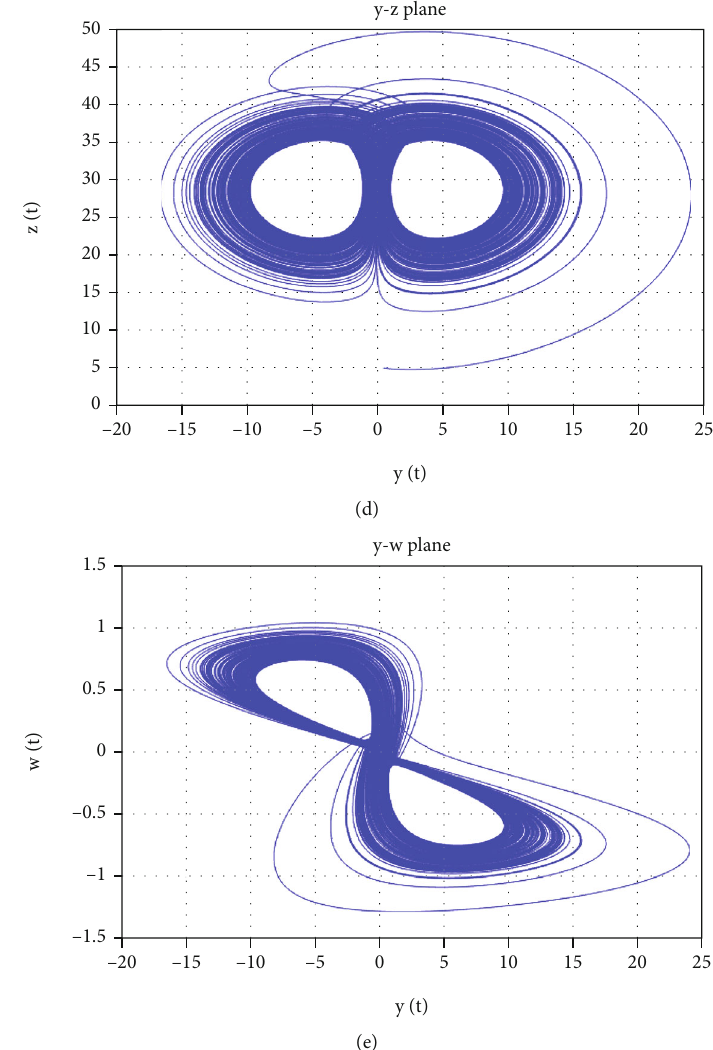
Figure 4: Attractors of the hyperchaotic LS system (5) projected on the planes: (a) x - y , (b) x - z , (c) x - w , (d) y - z , and (e) y - w